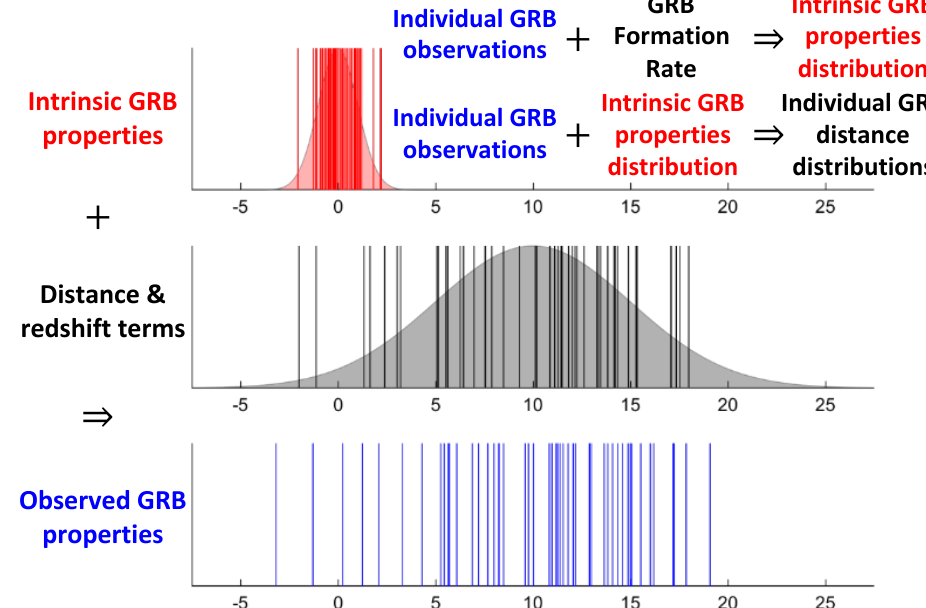
Figure 1. A schematic illustration of the proposed probabilistic approach to inferring the unknown GRB redshifts of the Fermi, Swift, and other catalogs of GRBs. All axes are